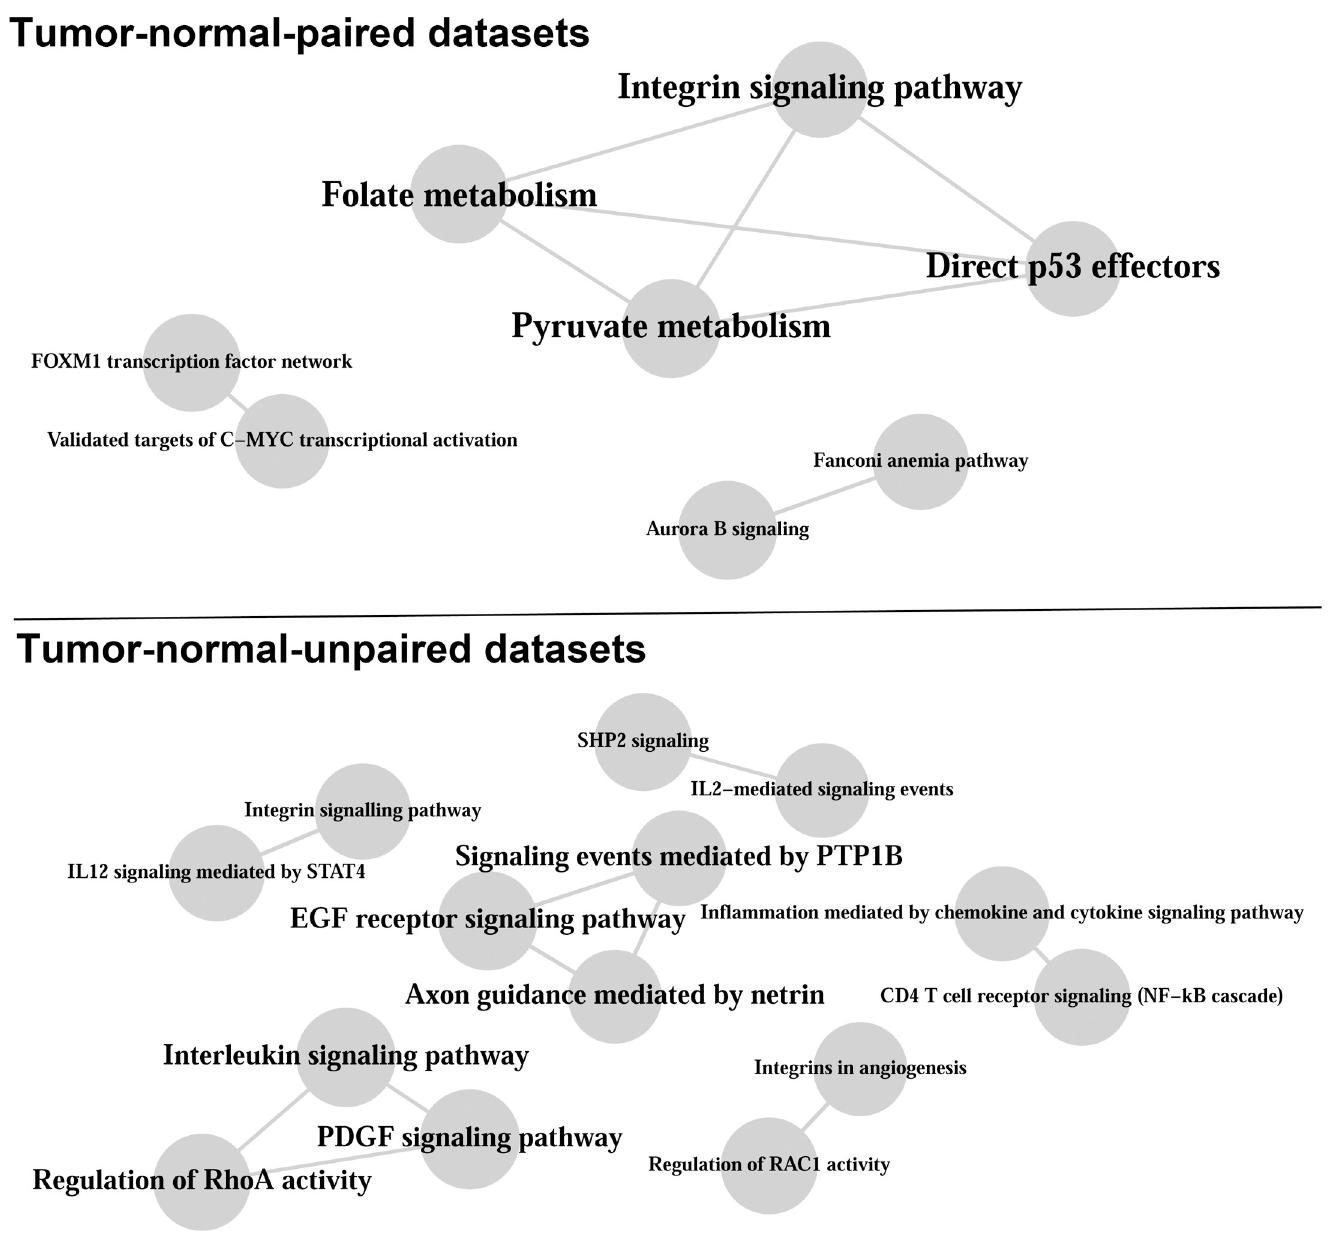
Fig 6. Pathway crosstalk network inferred from the meta-analysis of gene set differential coexpression across transcriptome datasets of 11 cancers. Significance thresholds of individual dataset p -statistic, meta-analysis p -statistic, and p -value of Pearson’s phi were all set at 0.01.